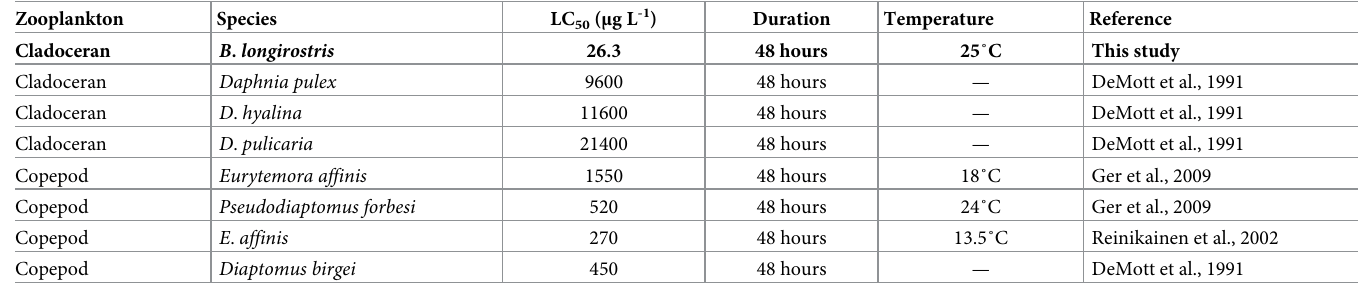
Table 1. Common zooplankton species and their corresponding LC 50 values when exposed to dissolved microcystin-LR. Dashes indicate value not reported. Zooplankton